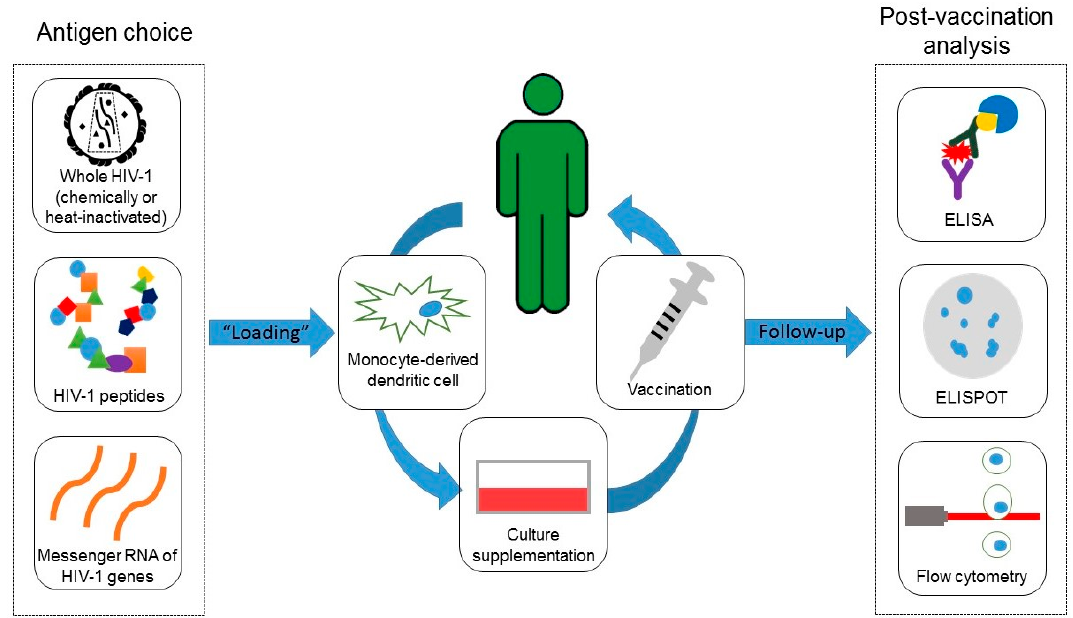
Figure 1. Rationale behind dendritic-cell based experimental anti-HIV-1 vaccines. Providing dendritic cells with specific antigen presentation will result in a reconditioning of host immune response against HIV-1, in the hopes that this will lead to a functional cure. The experimental vaccination protocols details vary, but they basically consist in choosing an antigen ( left panel), such as autologous (taken from the volunteer) whole virus that are heat- or chemically-inactivated ( top left panel), viral peptides such as gag or pol residues, for example ( middle left panel) or even viral messenger RNA molecules ( bottom left panel). Following antigen choice, dendritic cells must be obtained for vaccine preparation ( center panel). Usually, leukocytes are collected through leukapheresis and monocytes are isolated and differentiated in vitro into immature dendritic cells. Then, dentritic cells (DCs) are "loaded" with the chosen antigen and activated with cytokine supplementation, for example with granulocyte-macrophage colony-stimulating factor (GM-CSF), interferon alpha and gamma (IFN- α and IFN- γ ), interleukins 4 and 6 (IL-4 and IL-6) and tumor necrosis alpha (TNF- α ) into mature DCs. Defined amounts of mature dendritic cells are then periodically injected in the individual. Usually, immune response is assessed before, and during vaccination follow-up, through methodologies such as enzyme-linked immunosorbent assay (ELISA), enzyme-linked immunospot (ELISPOT), flow cytometry or any combination thereof ( right panel), to evaluate (qualitatively and quantitatively) how it changed following vaccination.